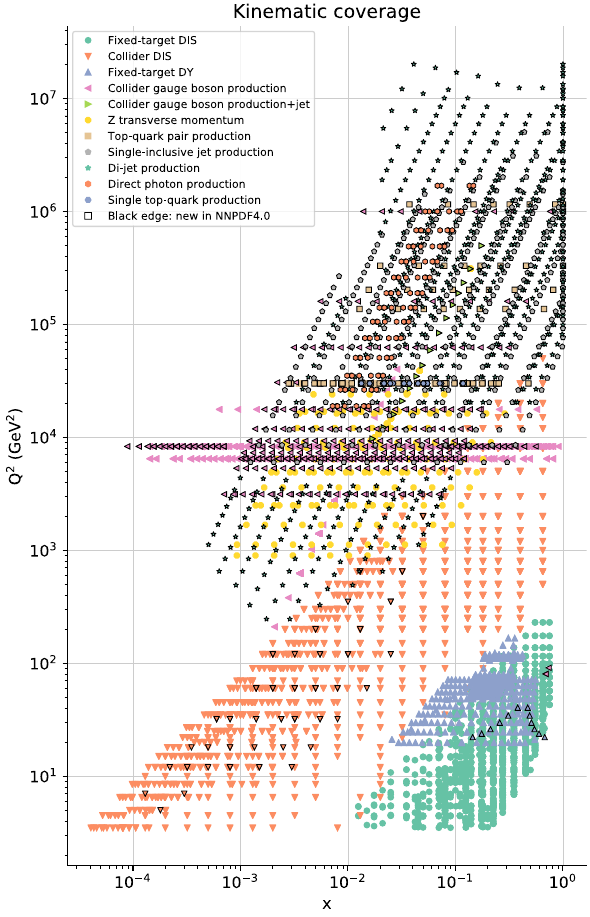
Fig. 2 ThekinematiccoverageoftheNNPDF4.0datasetinthe ( x , Q 2 )